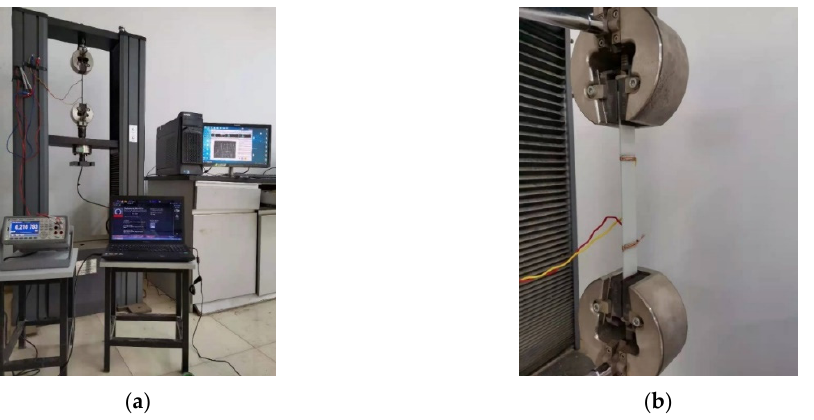
Figure 4. ( a ) The experimental set-up of the piezoresistive sensing test and ( b ) the CNM-incorporated FRP composites mounted in the UTM.